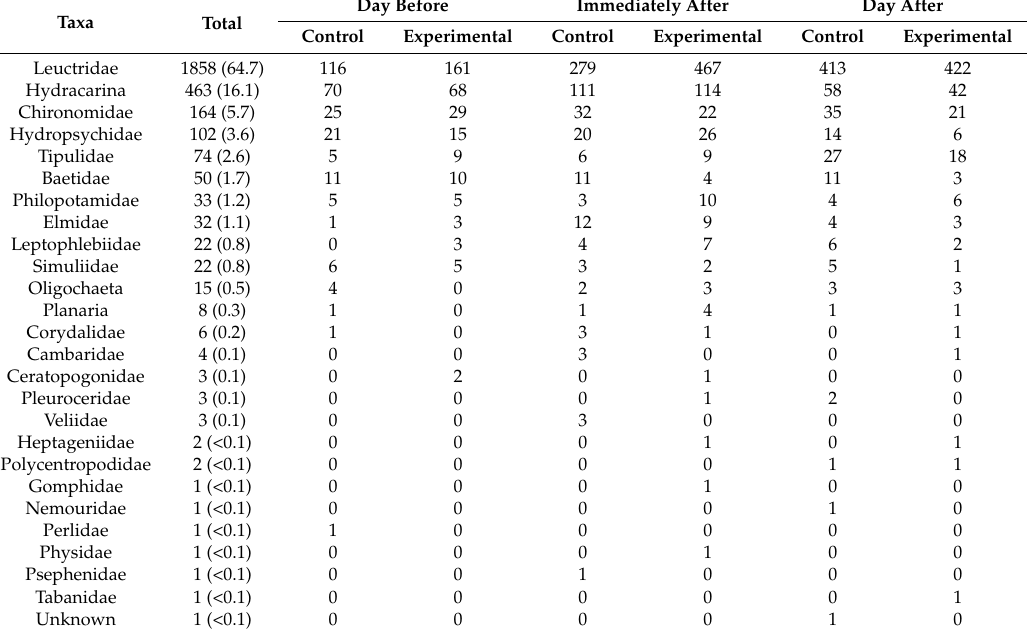
Table 3. Total number of captures (%) and number of captures of macroinvertebrate taxa on each day (one day before, immediately after, one day after experimental disturbance) within each site type (control, experimental) within three agricultural headwater streams of upper Alum